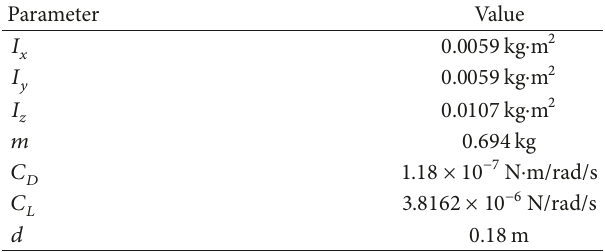
Table 2: Quadcopter UAV parameters [20].